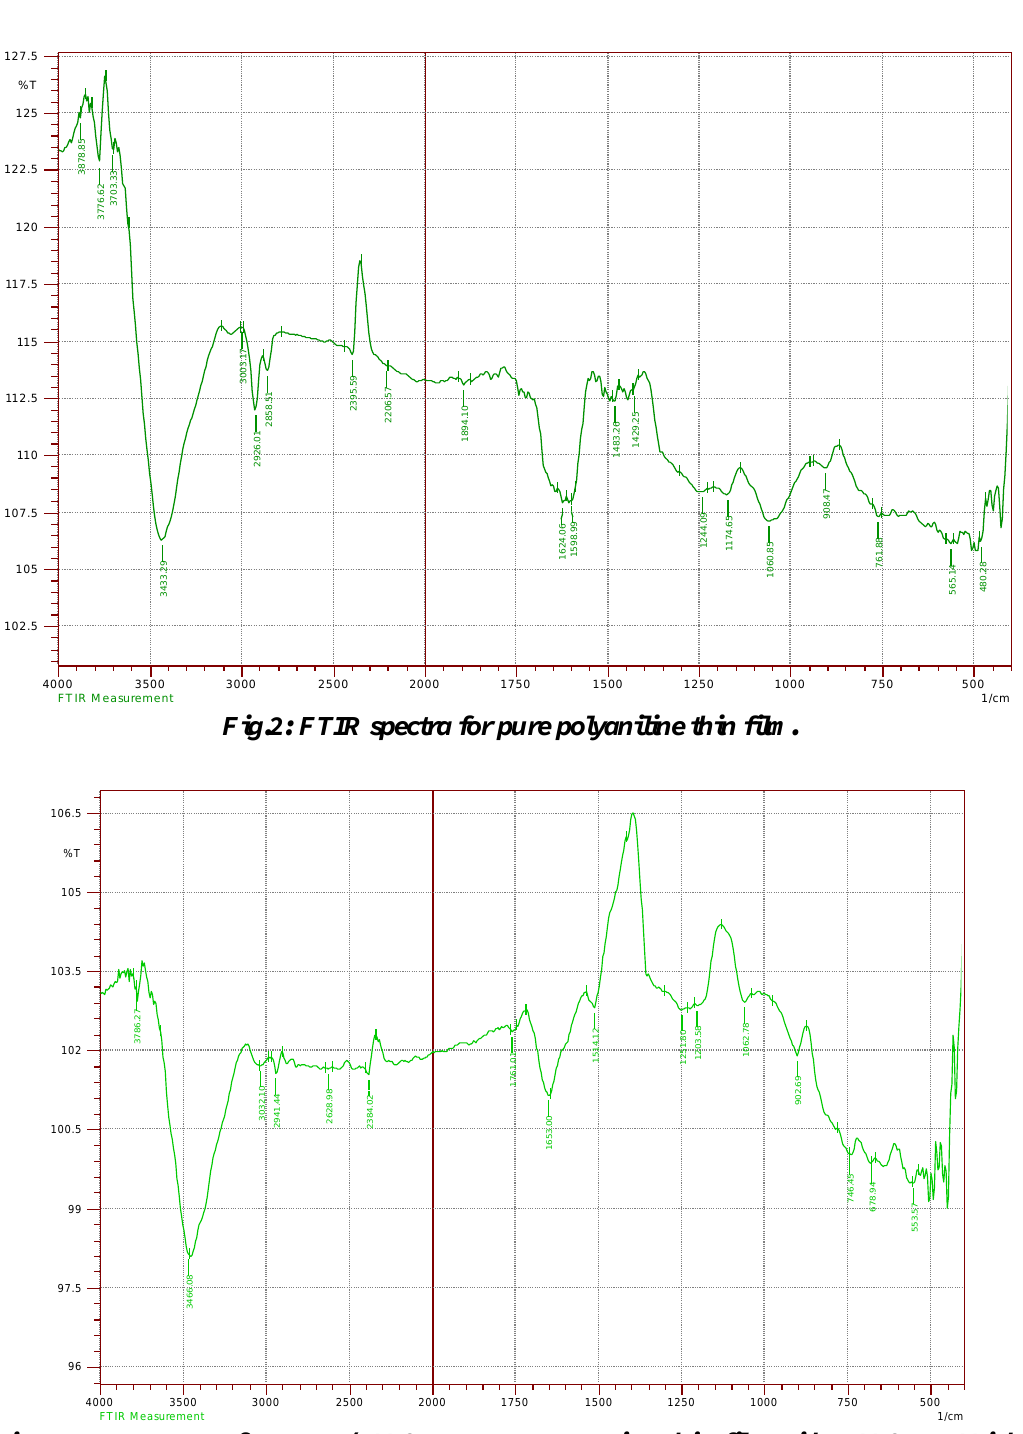
Fig.3: FTIR spectra for PANI/MWCNTs nanocomposites thin film with MWCNTs Wight concentration